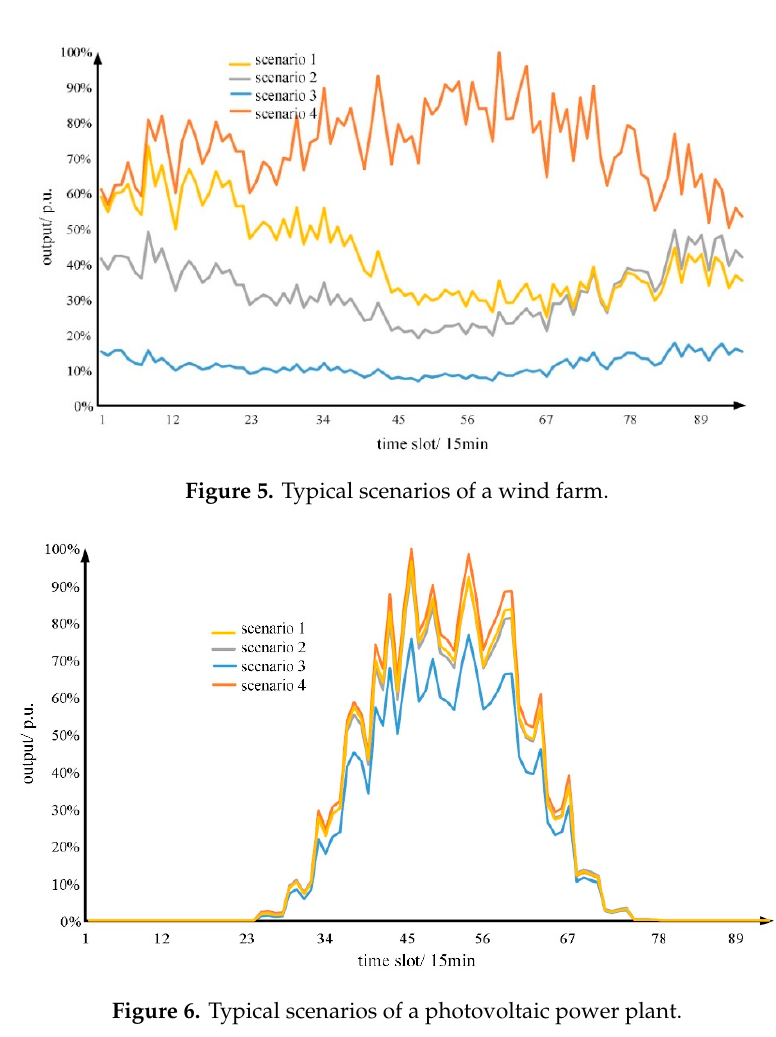
Figure 6. Typical scenarios of a photovoltaic power plant.